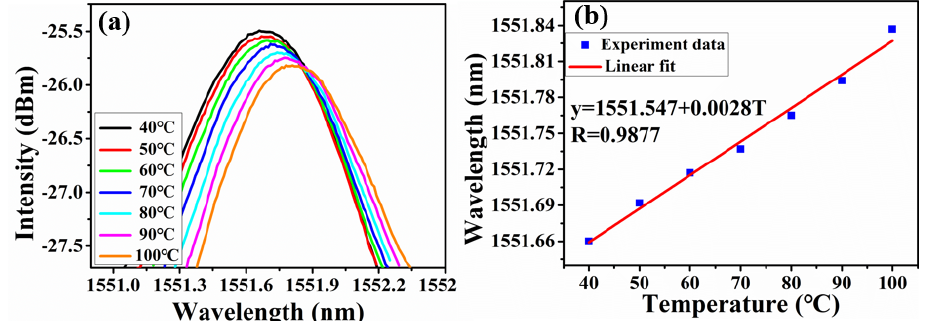
Figure 9. ( a ) Wavelength shift of the high-frequency fringe under different temperature; ( b ) calculated relative wavelength shift versus temperature.